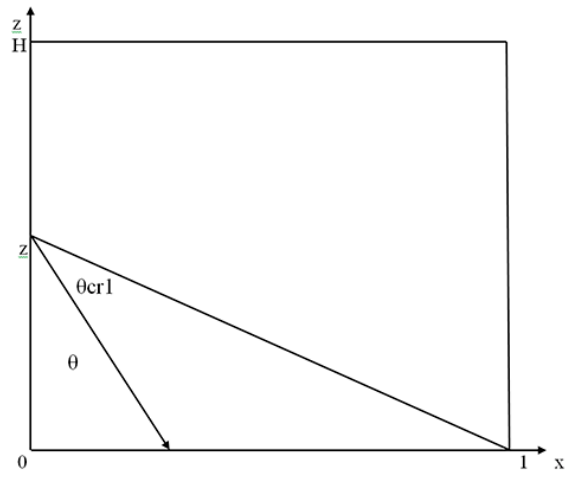
Fig. 6. Diagram of an atom entering the condensed phase after a collision with a wall.